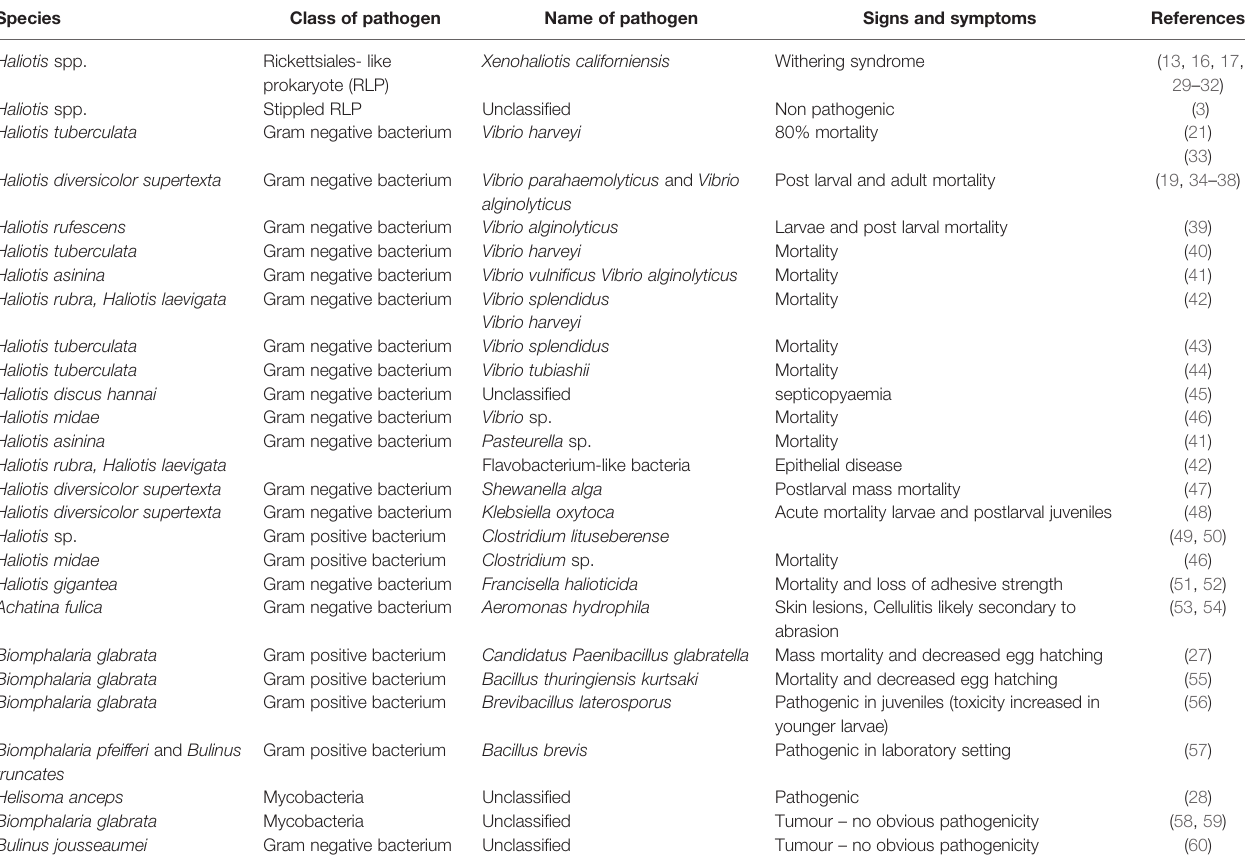
TABLE 1 | Bacterial diseases of gastropods.